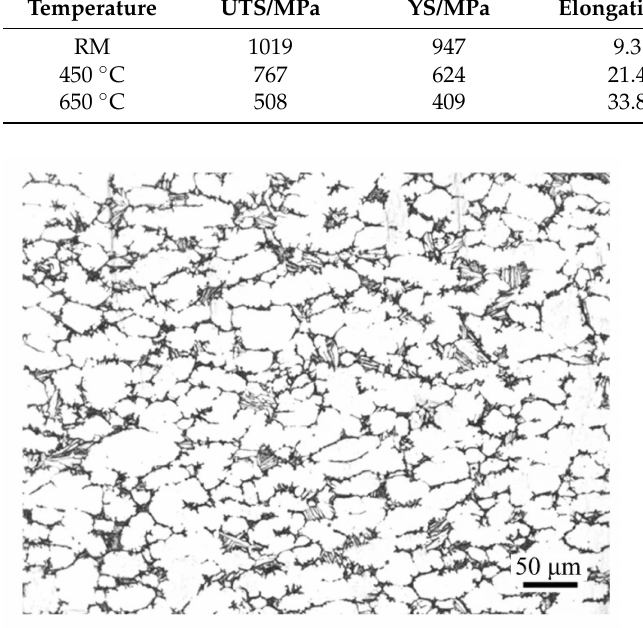
Figure 2. Microstructure of the as-received